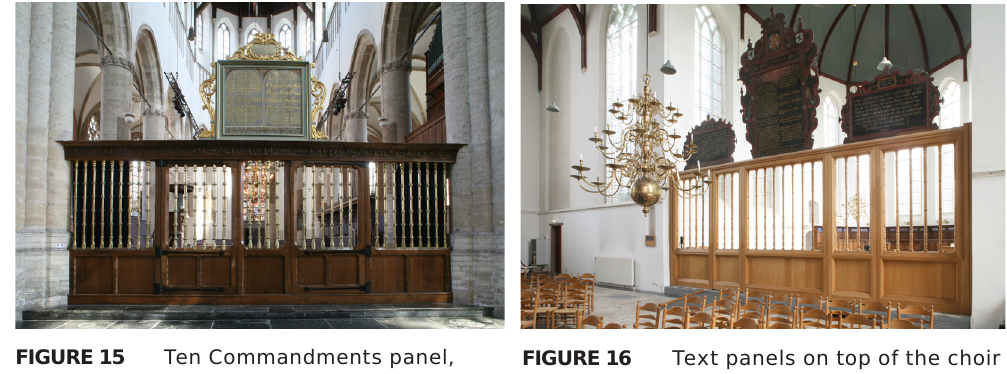
FIgure 15 Ten Commandments panel, FIgure 16 Text panels on top of the choir Leiden, c.1572-1625, photo screen, Noordwijk, 1624, photo archive Regnerus Steensma. archive Regnerus Steensma.